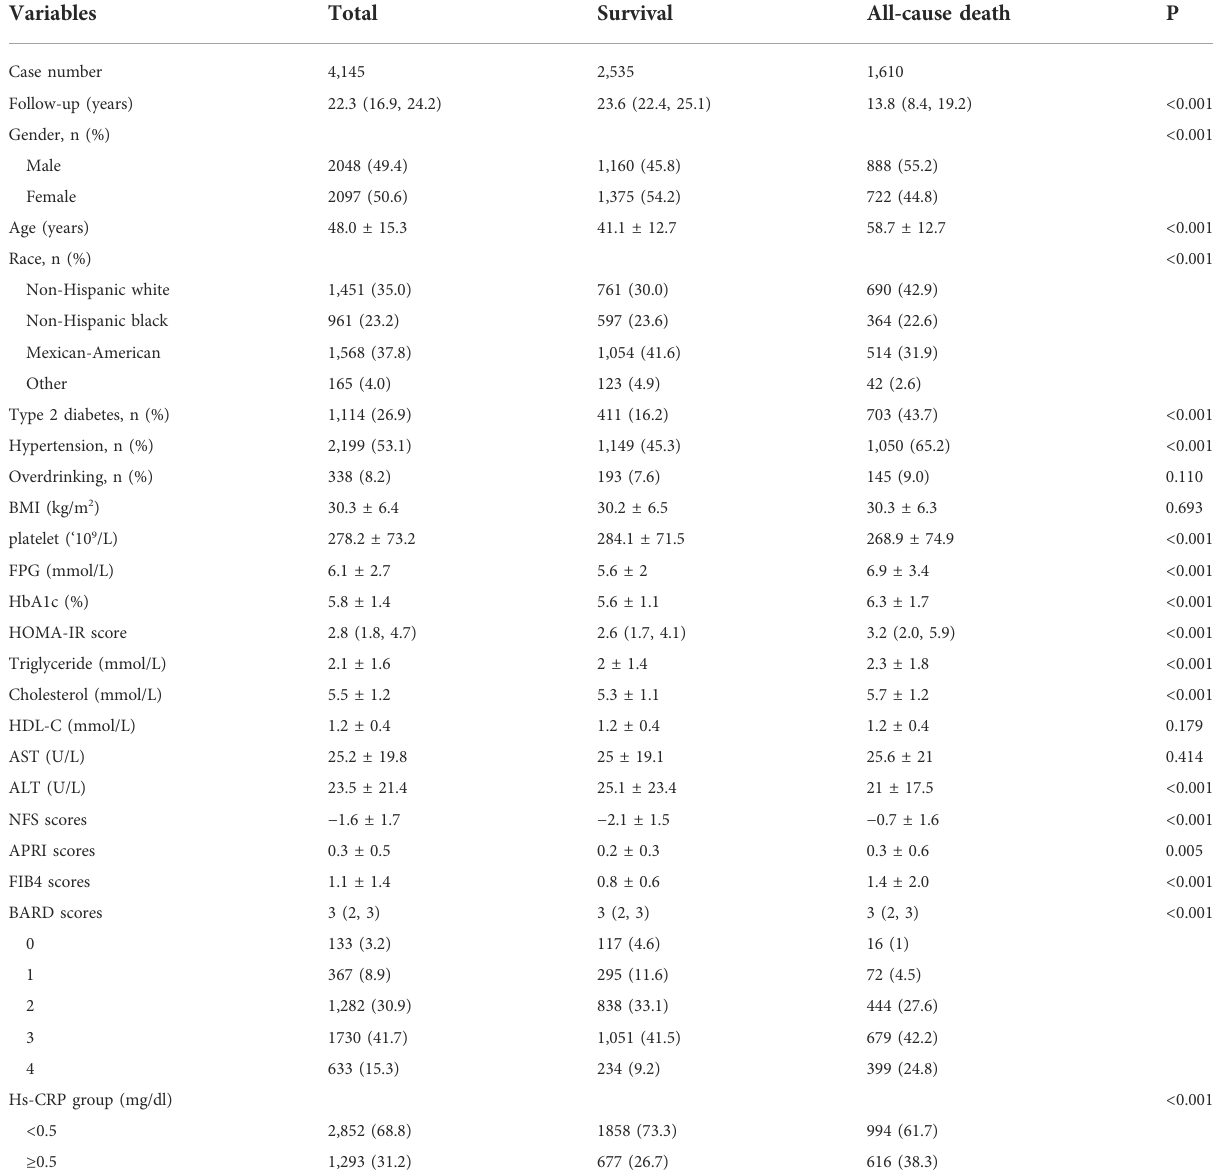
TABLE 1 Comparison between the survival and death